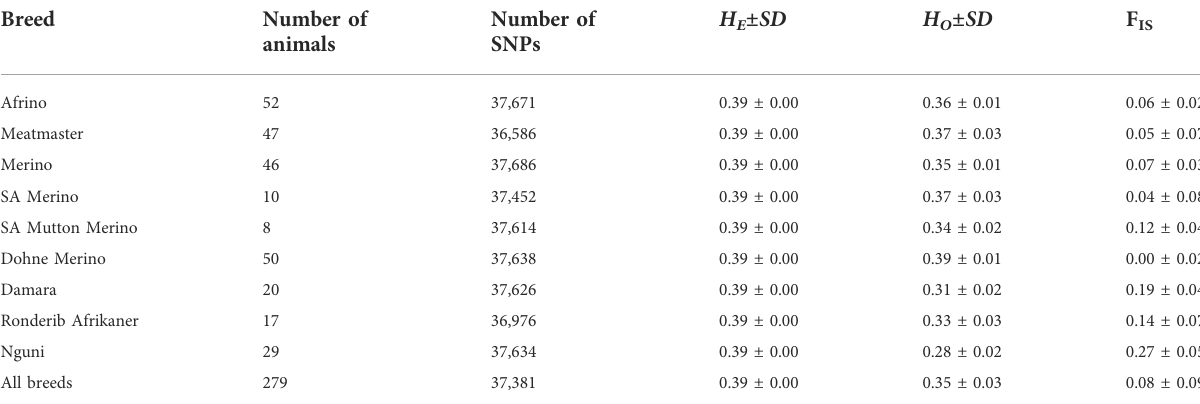
TABLE 2 Expected and observed heterozygosity in fi ve sheep breeds of South Africa.